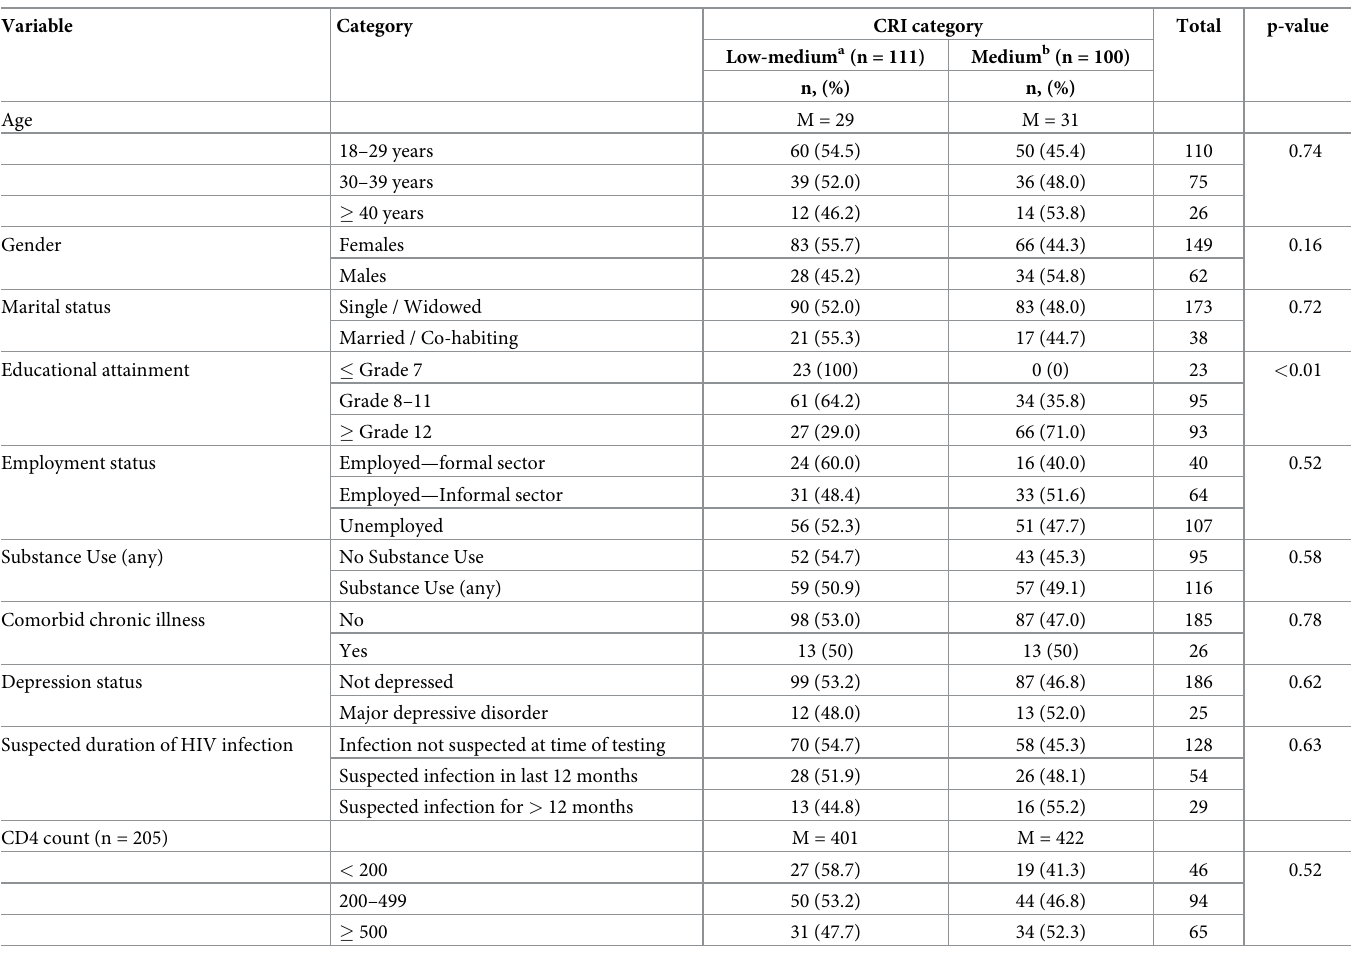
Table 2. Sociodemographic and clinical profile stratified by Cognitive Reserve Index (CRI) with p-values from univariate